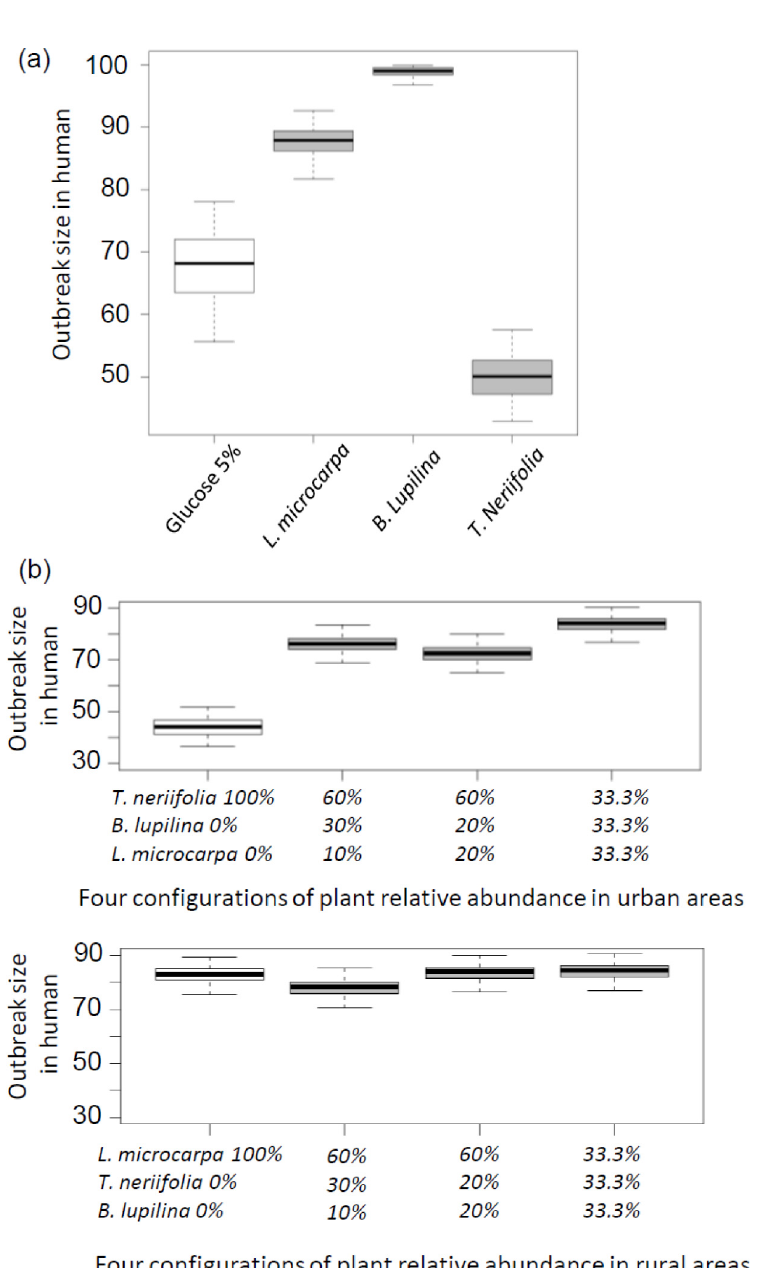
Fig 4. Theoretical difference in the distribution of outbreak sizes among plant sugars. (a) Epidemiological outcomes predicted by the model for each plant species considered in isolation, and (b) in a community perspective. In urban areas (upper panel), Thevetia neriifolia is relatively more abundant than Barleria lupilina and Lannea microcarpa . Four configurations with various relative abundances were considered: (i) a scenario of no diversity whereby T . neriifolia — the dominant plant — represents 100% of the feeding opportunities, (ii) a scenario of 60% T . neriifolia , 30% B . lupilina and 10% L . microcarpa , (iii) a scenario of 60 – 20 – 20%, and (iv) a scenario of equal feeding opportunities on each plant species. In rural areas (lower panel), L . microcarpa is relatively more abundant than T . neriifolia and B . lupilina . The same configurations as for urban areas were considered using this ranking. Outbreak size is the proportion of humans that has been infected at the end of the transmission season after one infectious human was introduced into the population. The box plots indicate the median (large horizontal bars), the 25 th and 75 th percentiles (squares), the minimum and maximum values (whiskers) and outliers